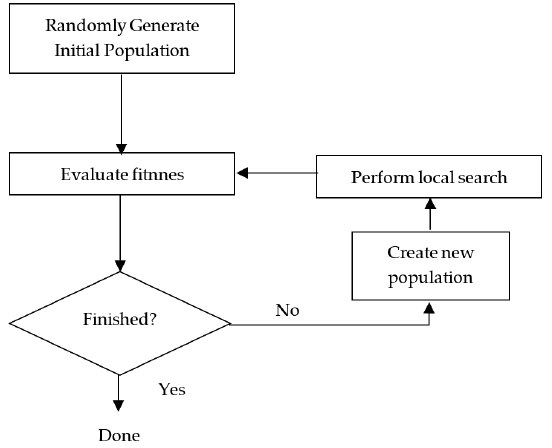
Figure 1. Flowchart for a simple MA